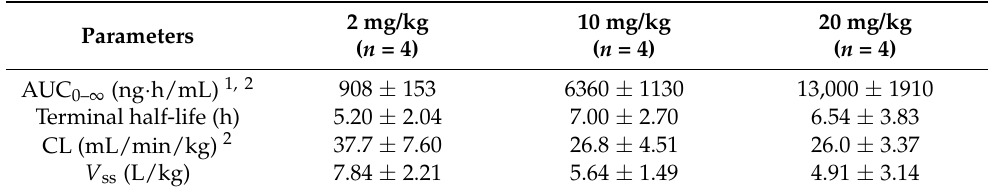
Table 2. Pharmacokinetic parameters (mean ± S.D.) for DA-6886 after single intravenous administra- tion at doses of 2, 10, and 20 mg/kg to rats.